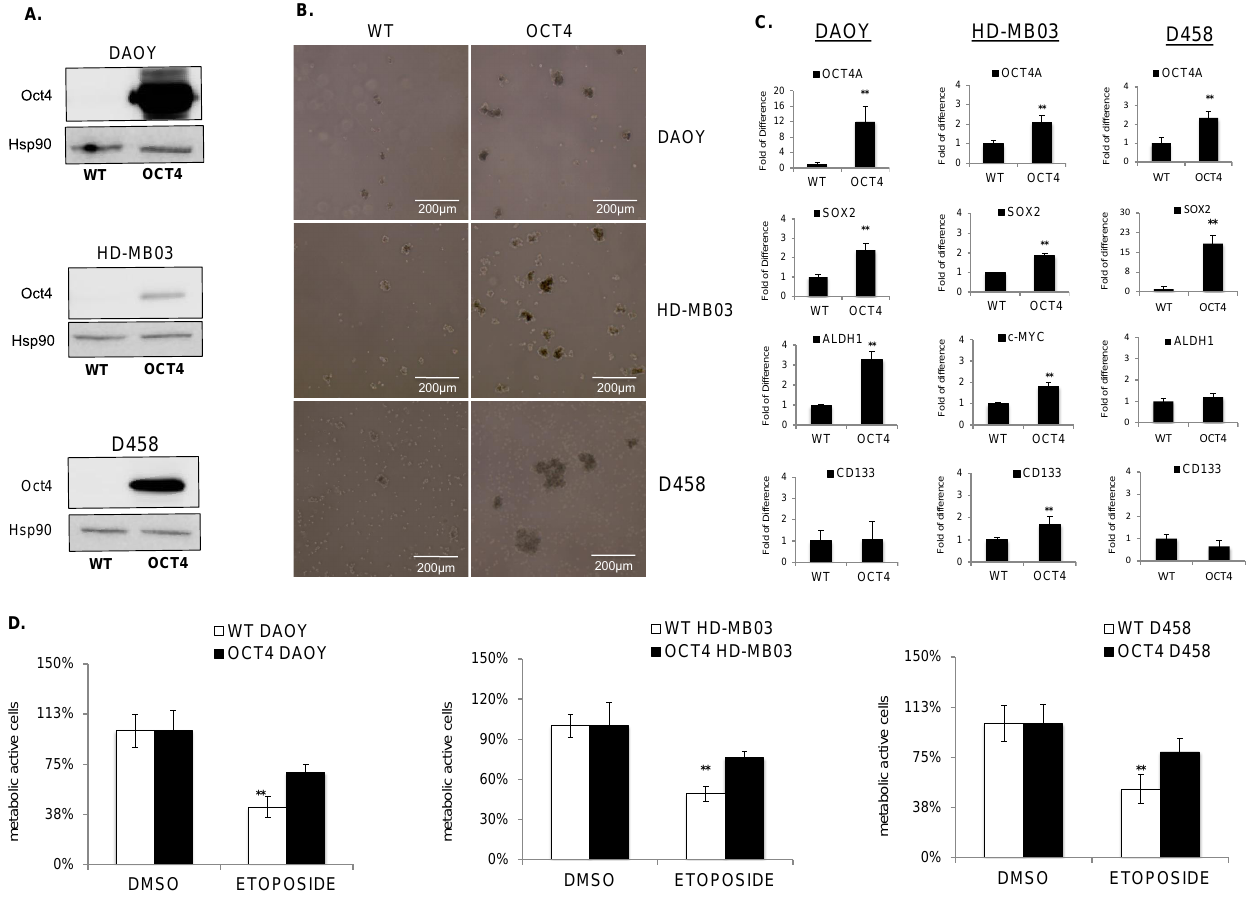
Figure 3. OCT4A enhances TICs and resistance to chemotherapy. ( A ) Immunoblot analysis shows the expression level of OCT4 protein after overexpression in DAOY, HD-MB03, and D458 cells. Hsp90 was used as a loading control. ( B ) Representative images of tumorsphere(s) generated from wildtype (WT) (left panel) and OCT4-expressing (OCT4) cells (right panel) generated from DAOY, HD-MB03, and D458 cell lines as indicated. ( C ) qPCR analyses showing the expression level of OCT4A, CD133, SOX2, and ALDH1 in wildtype (WT) and OCT4-overexpressing (OCT4) cell lines as indicated. ** p < 0.01, according to two-tailed paired Student’s t-test. Data are the mean ± SD. ( D ) Cytotoxic effect analyzed in MTT assays of etoposide in parental (WT) and OCT4-overexpressing (OCT4) HD-MB03, DAOY, and D458 cells related to DMSO treated counterpart (DMSO). The original blots could be found in the Figure